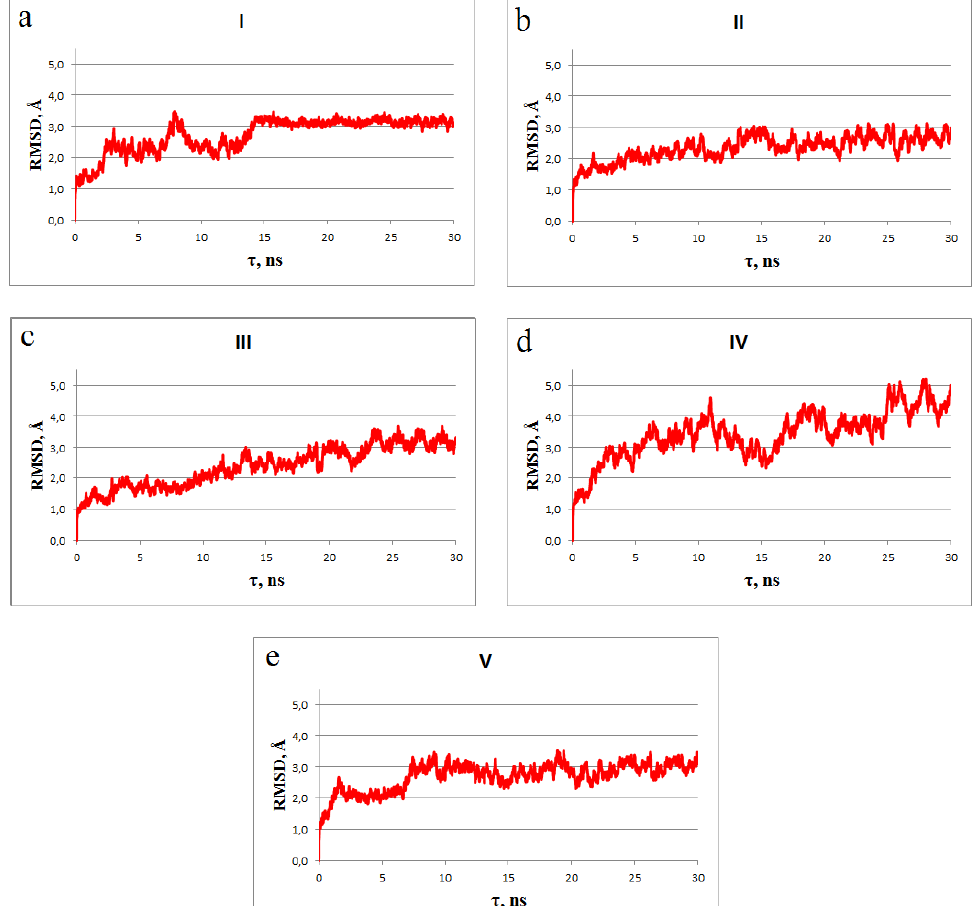
Figure 7. The time dependence of the root-mean square deviations ( RMSD) (Å) computed between all of the MD structures and the stating models of the ligand–gp120 complexes. The backbone atoms of gp120 were used in the calculations. The RMSD averages are: compound I–gp120 complex ( a ) −2.71 ± 0.31 Å, compound II–gp120 complex ( b ) −2.30 ± 0.16 Å, compound III–gp120 complex ( c ) −2.28 ± 0.39 Å, compound IV–gp120 complex ( d ) − 3.07 ± 0.60 Å, and compound V–gp120 complex ( e ) − 2.67 ± 0.21